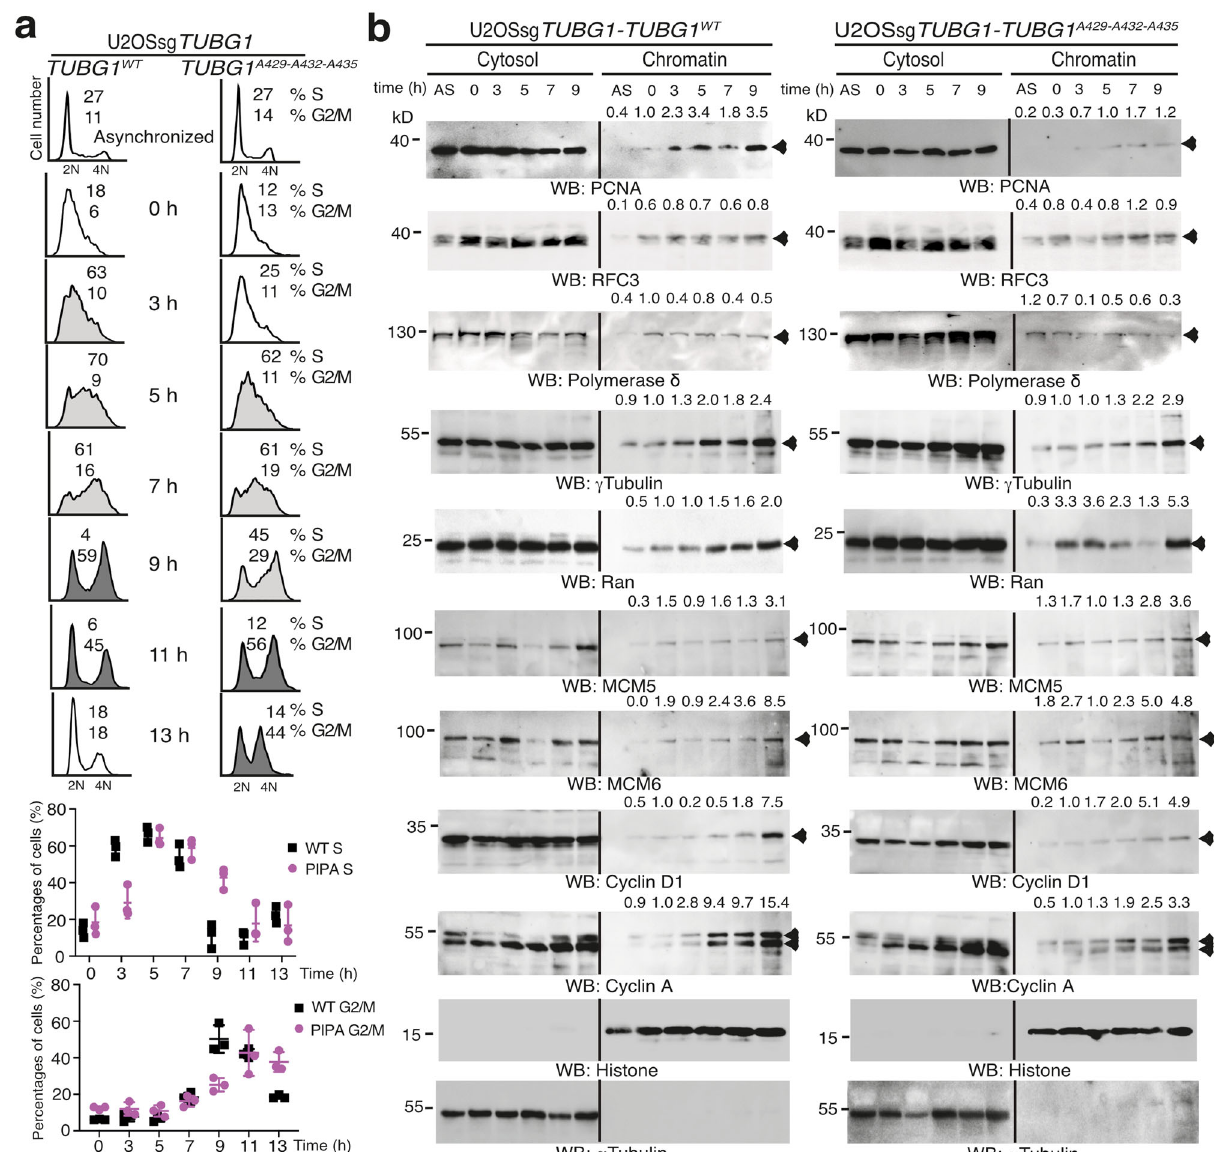
Fig. 8 The γ -tubulin PIP mutant does not prevent the licensing of DNA replication. a , b Analysis of the DNA ( a ) and protein ( b ) content in asynchronized (AS) and double thymidine block-synchronized TUBG sg-U2OS (U2OSsg TUBG1 ) cell line co-expressing single-guided (sg)-resistant γ -tubulin (TUBG1 WT ) or a γ -tubulin A429-A432-A435 (TUBG1 A429-A432-A435 ). a The data on each cell population are presented as the proportion of cells in S phase (<40% [black open histograms], >40% [light gray closed histograms]), or G2/M phase (>40% [dark gray closed histograms]). The graphs show the percentage of cells in S or G2/M phase (mean ± SD; N = 3, **** P < 0.0001; see also Supplementary Figs. 2, 10, and 11). b U2OSsg TUBG1 - TUBG1 WT and U2OSsg TUBG1 - TUBG1 A429-A432-A435 cells were lysed, and proteins were biochemically divided as in Fig. 2b and then analyzed by WB with the indicated antibodies. α - Tubulin and histone were used as molecular markers for the cytosolic and nuclear fractions, respectively. Arrowheads indicate protein for which accumulation in the chromatin fraction varies during cell division. Numbers on the WBs indicate relative variations in accumulation of the proteins PCNA, RFC3, DNA polymerase δ , γ -tubulin, Ran, MCM5, MCM6, cyclin D, and cyclin A in the chromatin fraction. To adjust for differences in protein loading, for each sample, the concentration of an individual protein was determined by its ratio with histone ( N = 3). a , b Source data are provided in Supplementary Data